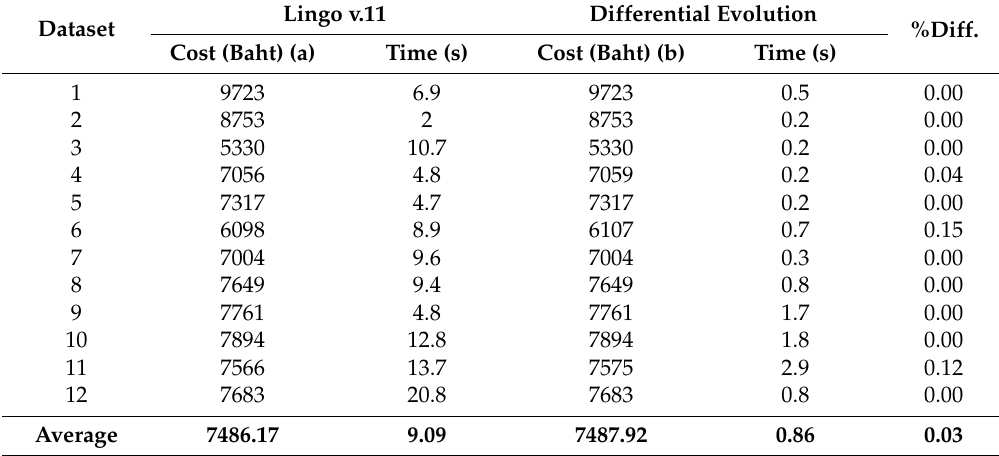
Table 17. Results of small samples (5 × 5) showing cost and time of